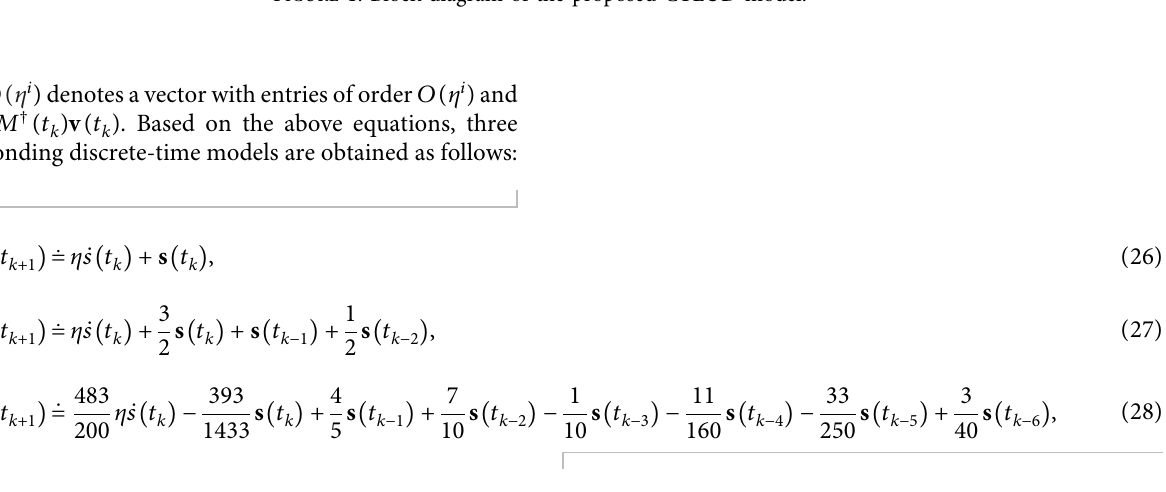
Figure 1: Block diagram of the proposed CTLUD